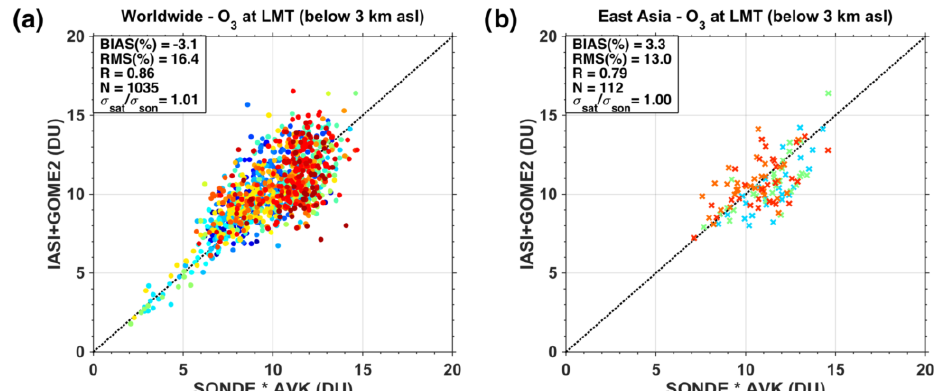
Figure 1. Validation of IASI + GOME2 retrieval of O 3 (in Dobson units, DU) in the LMT (between the surface and 3kma . s . l . ) by comparison with ozonesondes during 2009 and 2010 launched from (a) 46 stations spread worldwide and (b) 3 Japanese stations (Sapporo, Tateno and Naha) in the region 25–45 ◦ N, 110–150 ◦ E. Averaging kernels of IASI + GOME2 are used for smoothing ozonesonde measurements for accounting for satellite retrieval sensitivity. The symbol σ sat /σ sonde is the ratio between the SDs of the sonde data and the satellite retrievals. Table 1. Validation of IASI + GOME2 ozone retrievals in the LMT against ozonesondes measurements from 46 stations distributed world- wide (and over East Asia in the region 25–45 ◦ N, 110–150 ◦ E, i.e. 3 Japanese stations) launched in 2009 and 2010, during all seasons. We account for the satellite retrieval sensitivity by smoothing ozonesonde profiles with averaging kernels of IASI + GOME2 pixels with centres collocated within ± 1 ◦ of latitude and longitude from the station launching the sonde. Ozonesonde-derived LMT ozone columns are calcu- lated by vertical integration and compared with the average of IASI + GOME2 collocated retrievals. Biases and rms differences are given in Dobson units (DU), and percentage in parentheses. Scatter plots of these datasets are provided in Fig. 1. IASI + GOME2 retrievals at Ozonesondes distributed Ozonesondes over the LMT vs. ozonesondes worldwide East Asia Bias − 0.31 ( − 3.1%) 0.37 (3.3%) Correlation 0.85